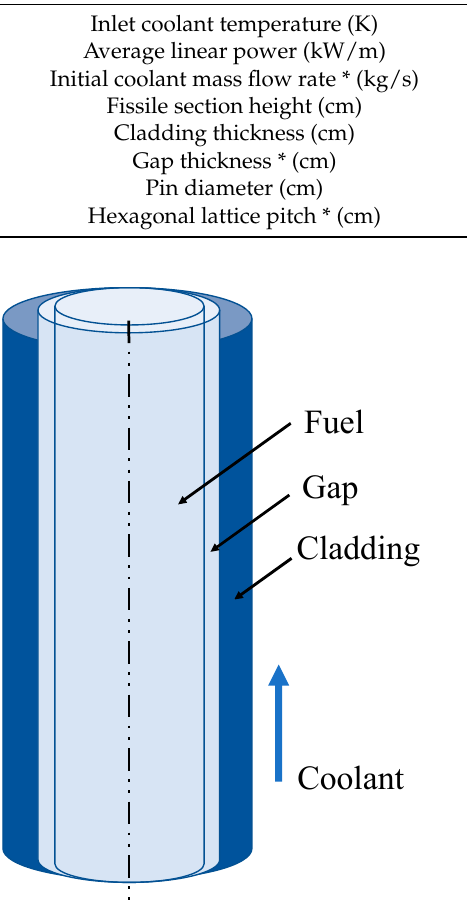
Figure 1. Pin geometry–axial geometry of the pin-coolant system.